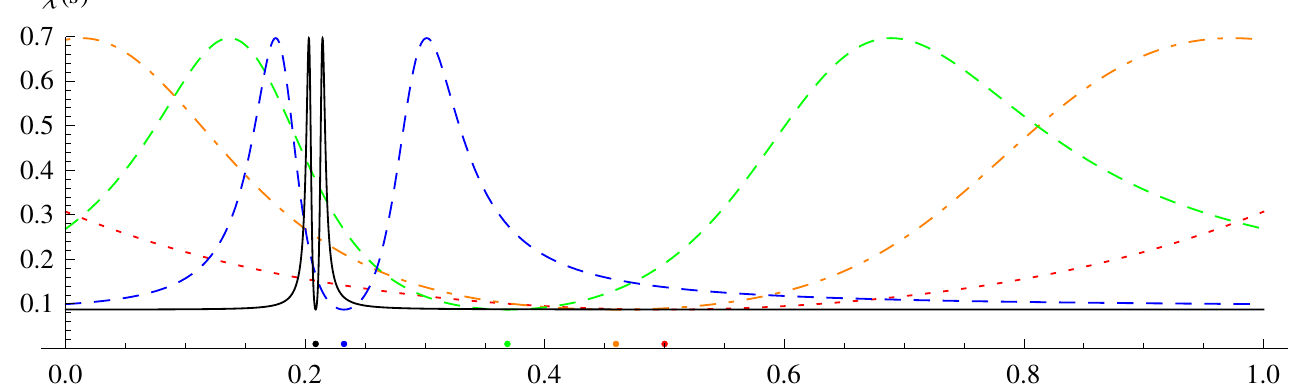
Figure 3. The generalized curvature χ ( ¯ s ) of ( C 1 ( ¯ s ) , D 1 ( ¯ s )) for evolution parameters φ = 0 (red, dotted), φ = 0.05 (orange, dot-dashed), φ = 0.1 (light green, dashed), φ = 0.2 (dark blue, dashed), and φ = 0.4 (black,